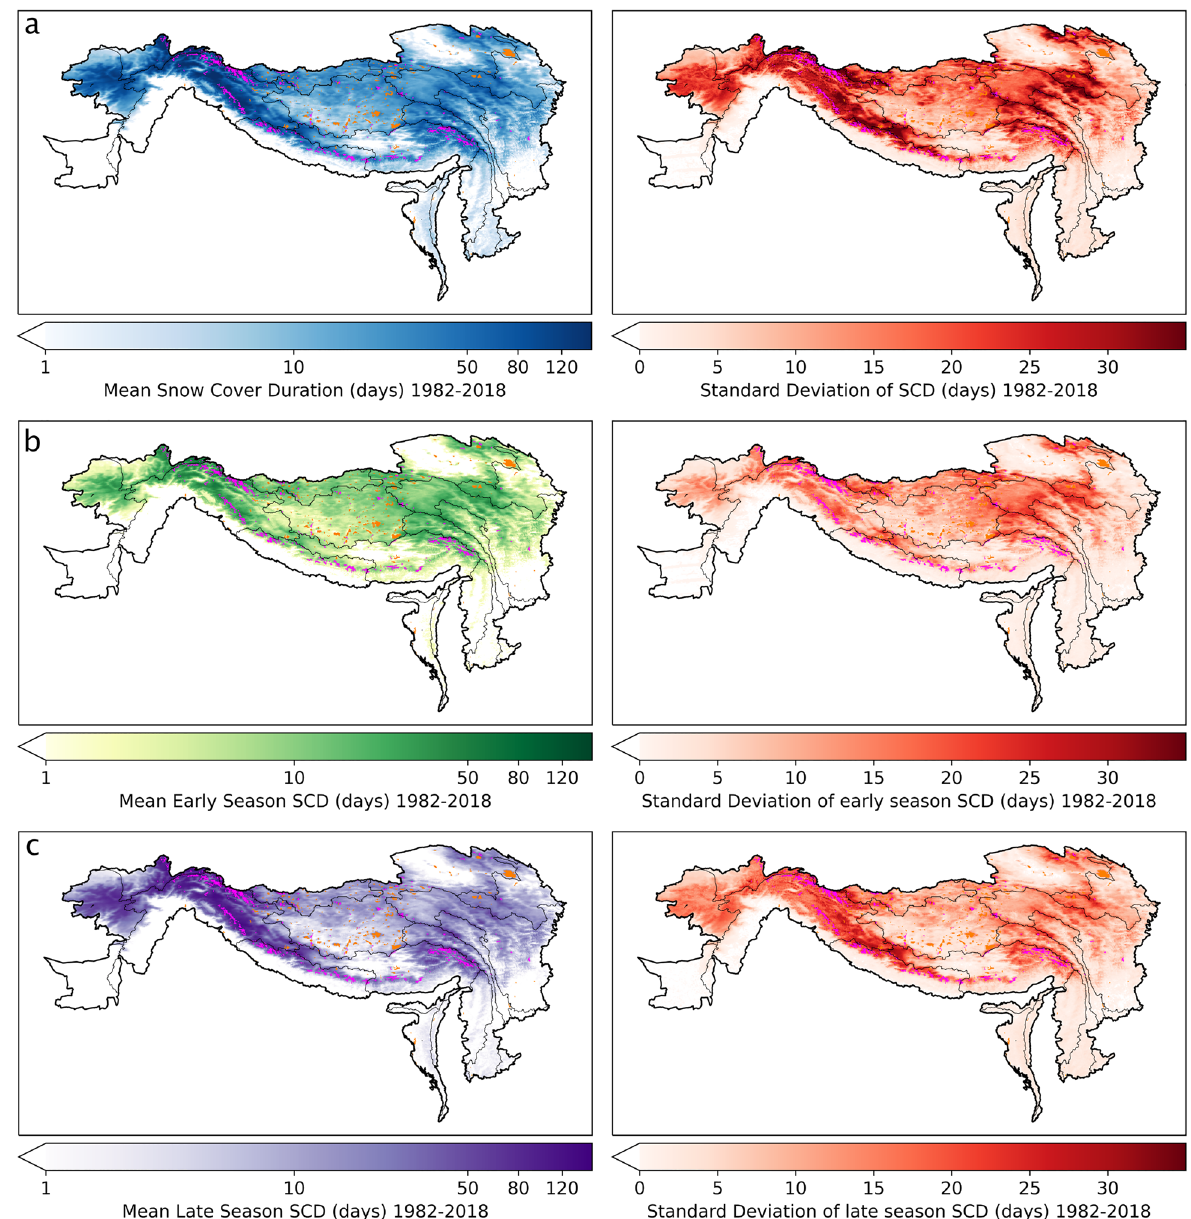
Figure 2. Seasonal Snow Cover regime and its variability over time ( a ) Mean snow cover duration (left). ( b ) Mean early season snow cover duration, SCD es (left). ( c ) Mean late season snow cover duration, SCD ls (left). Standard deviations of mean SCD, SCD es and SCD ls are given in the right column. All displays present averaged data between 1982 and 2018. Early season is defined as between 1 September and 15 January of a given hydrological year, while late season is defined as between 16 January and 31 August. Permanent ice is displayed in pink, masked water bodies in orange. Geolocation and scale according to Fig.